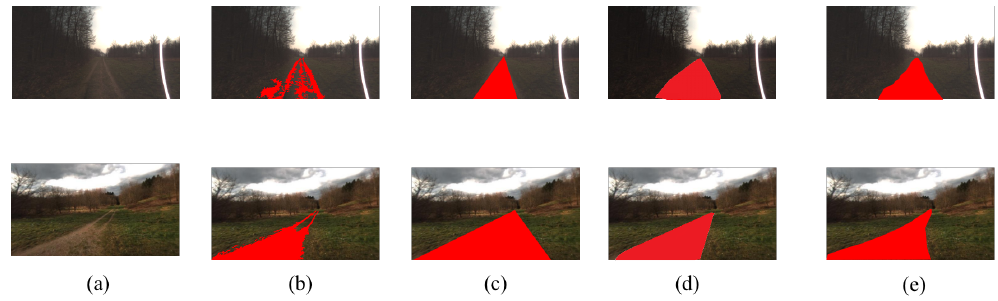
Figure 1. Visualization results of different methods for road detection. Our ARDformer is significantly better than other methods. ( a ) Input image, ( b ) segmentation-based, ( c ) rule-based, ( d ) ARDformer, ( e ) ground